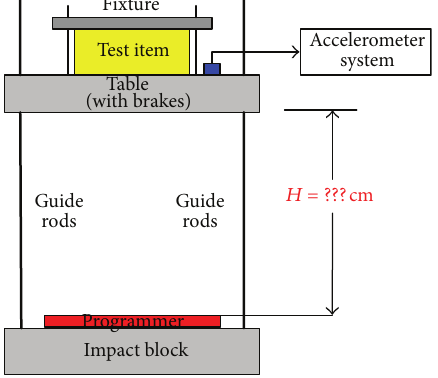
Figure 1: A free-fall shock test machine.